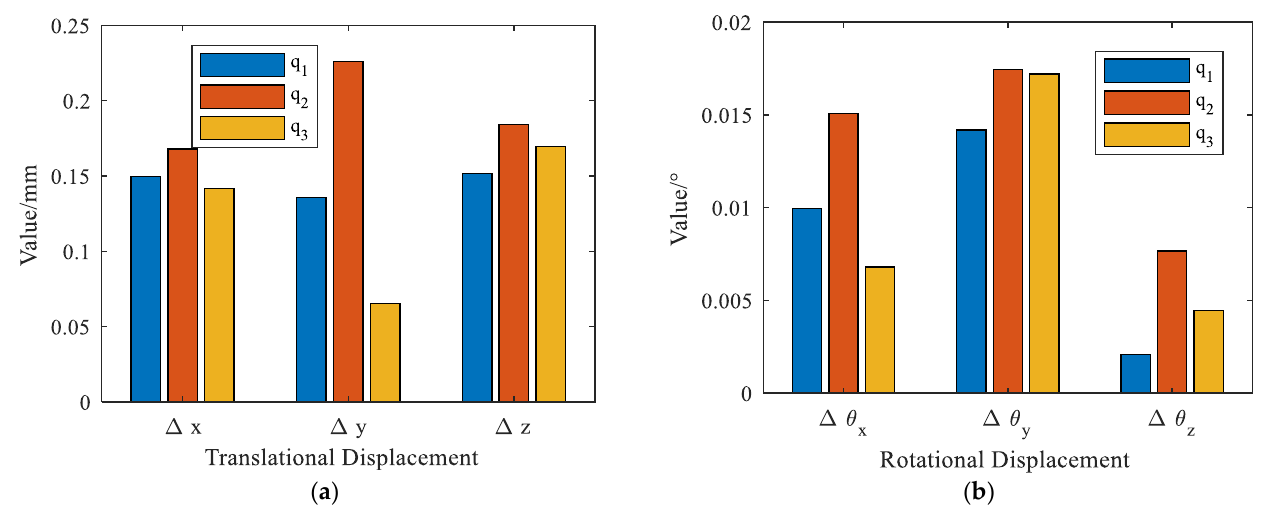
Figure 5. The generalized displacements of the end effector of the humanoid manipulators with different joint output angles. ( a ) Translational displacements of the end effector; ( b ) Rotational displacements of the end effector.